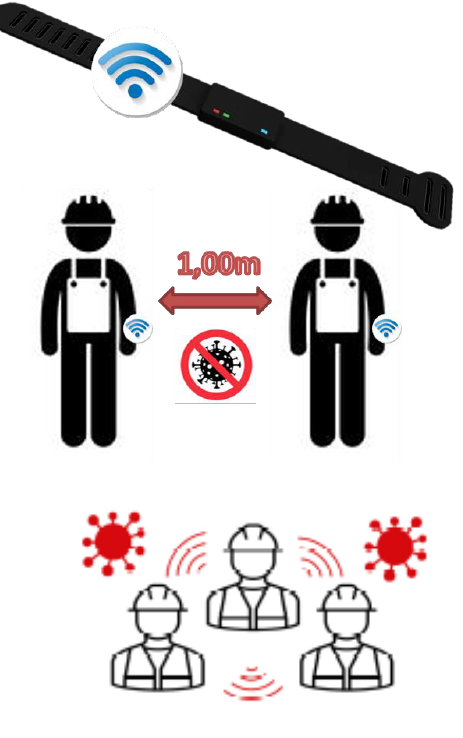
Figure 1 : Schematic operation of the anti-Covid 19 device.